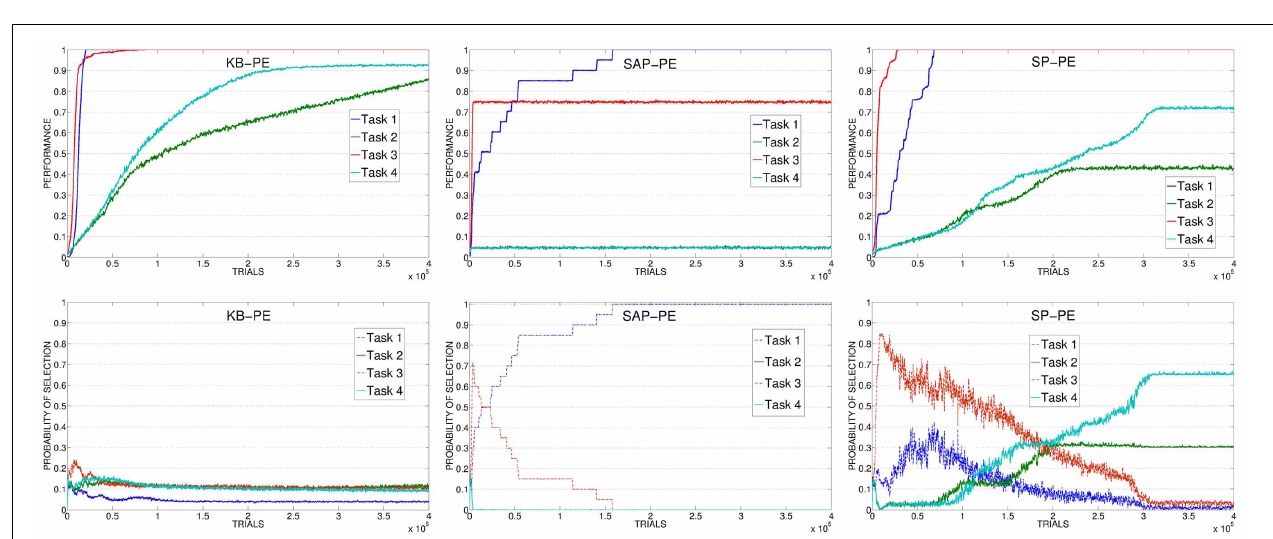
performance is reported inside the bar. Right : Average performance achieved by the system in the worst replication of each experimental condition.